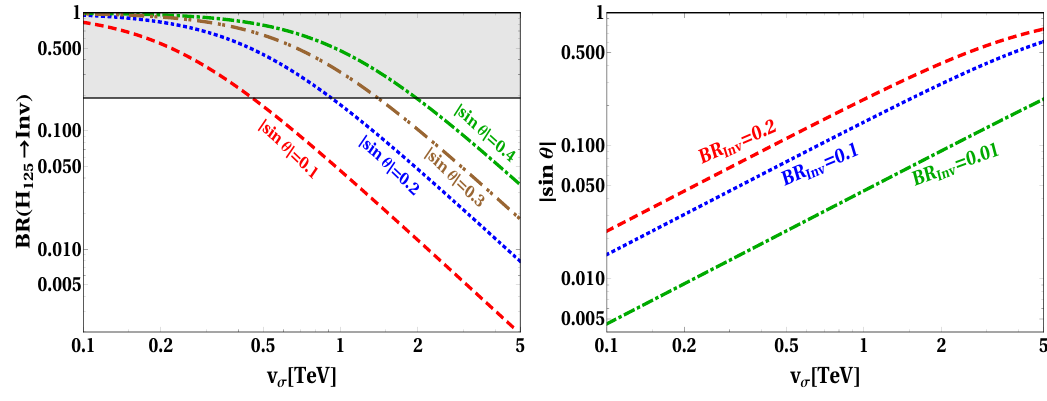
Figure 11 . Left panel : BR ( H 125 → Inv ) vs | sin θ | for different choices of | sin θ | = 0 . 1 (red dashed), 0.2 (blue dotted), 0.3 (brown double dot-dashed) and 0.4 (green dot-dashed). The black shaded region is excluded by the LHC limit in eq. (1.2). Right panel : exclusion contours in the plane | sin θ | vs v corresponding to an invisible Higgs branching ratio BR ( H σ dashed), 10% (blue dotted) and 1% (green dot-dashed), respectively. The regions above each line are